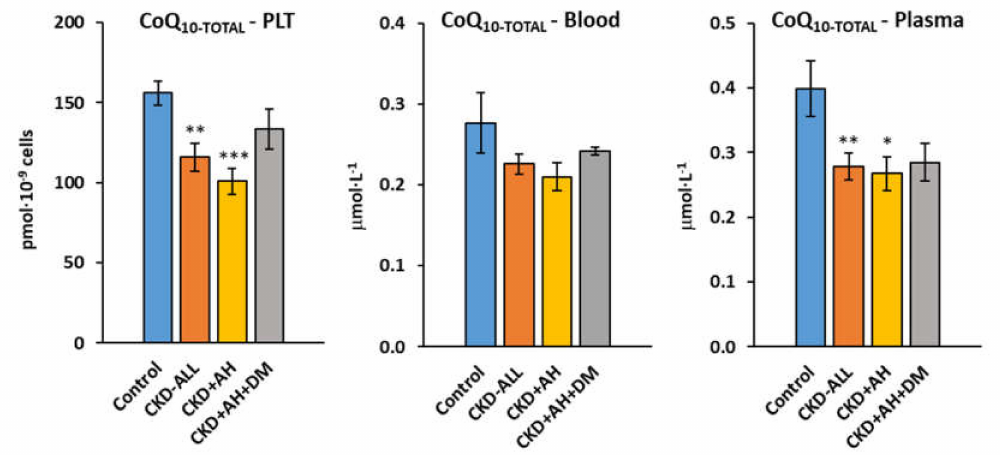
Figure 3. Endogenous coenzyme Q 10-TOTAL in platelets, blood, and plasma in control subjects and groups of CKD patients. Legend: coenzyme Q 10 (CoQ 10 ) -TOTAL (ubiquinol and ubiquinone); PLT—platelets; * p < 0.05; ** p < 0.01; and *** p < 0.001. Control—the group of healthy subjects ( n = 12); CKD-ALL—all patients with chronic kidney disease ( n = 27); CKD + AH—the subgroup of CKD-ALL patients with arterial hypertension ( n = 17); CKD + AH + DM—the subgroup of CKD-ALL patients with arterial hypertension and diabetes type 2 ( n =